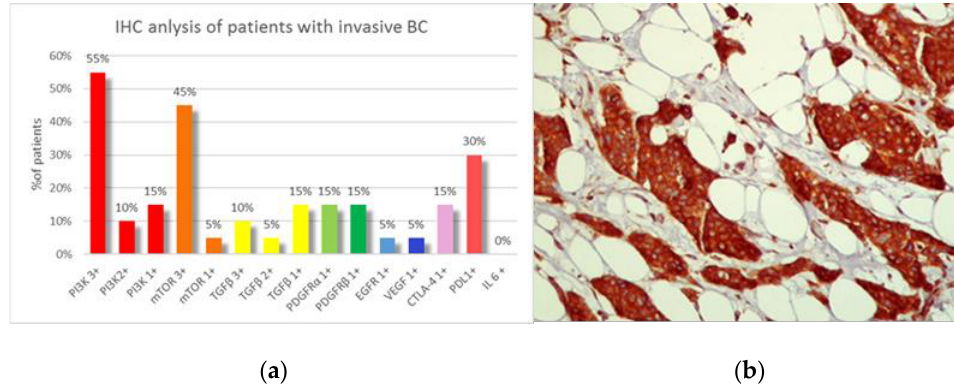
Figure 1. ( a ): Immunohistochemical analysis of samples of patients with invasive BC (20 patients). ( b ): Histological sample of BC with PI3K over-expression (score 3+).